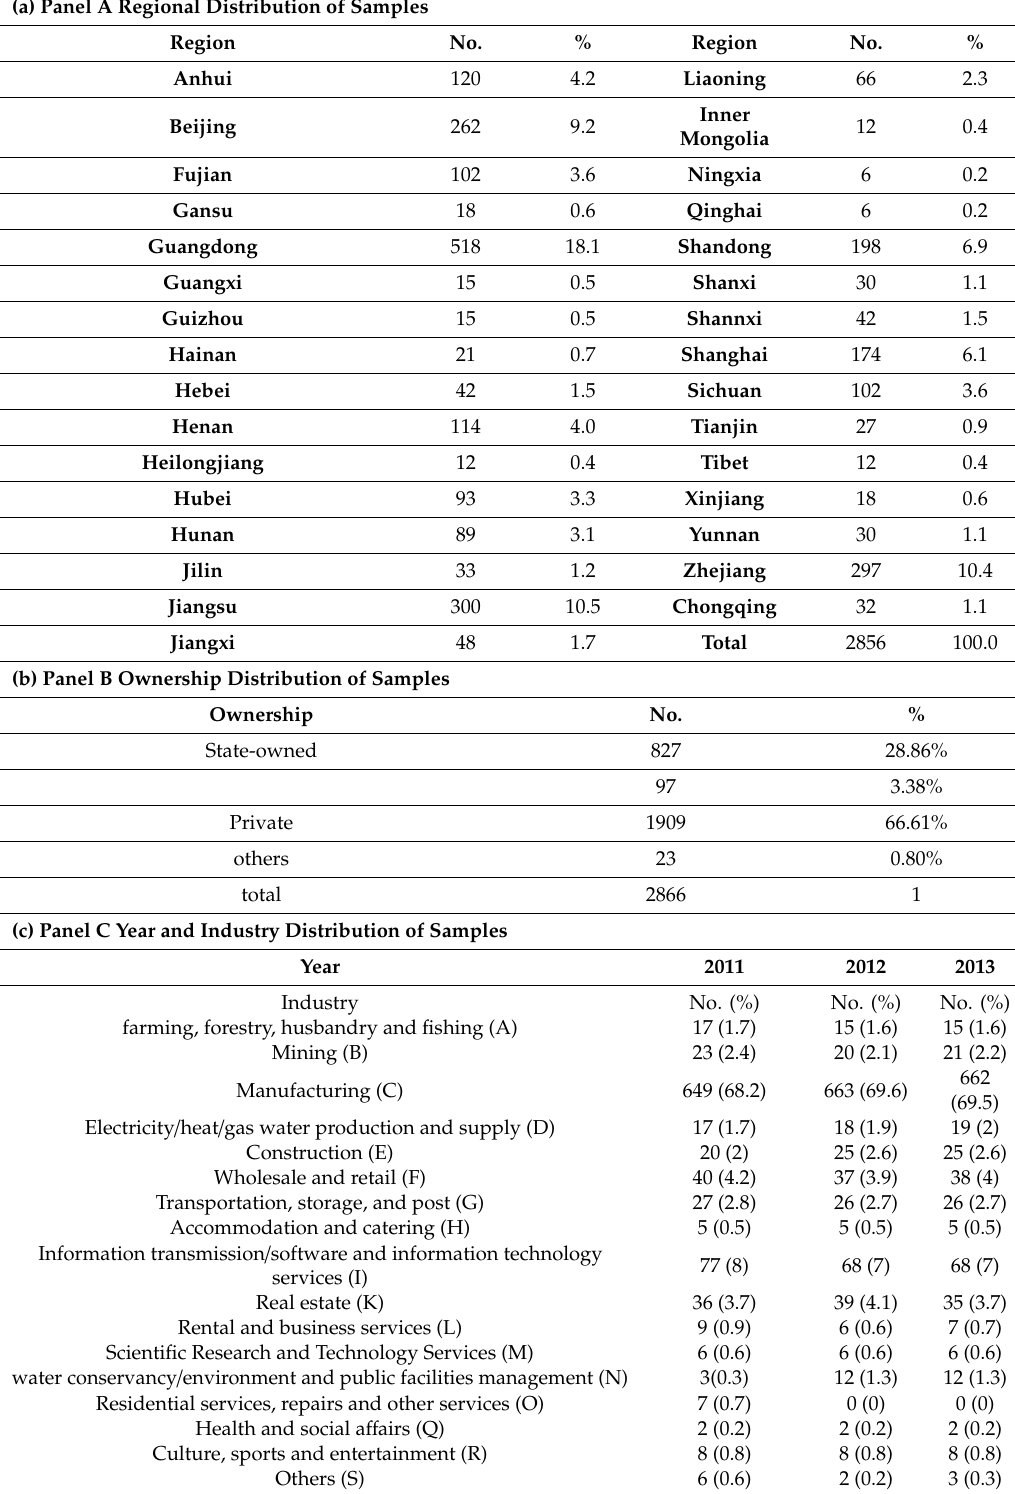
Table 2. Summary